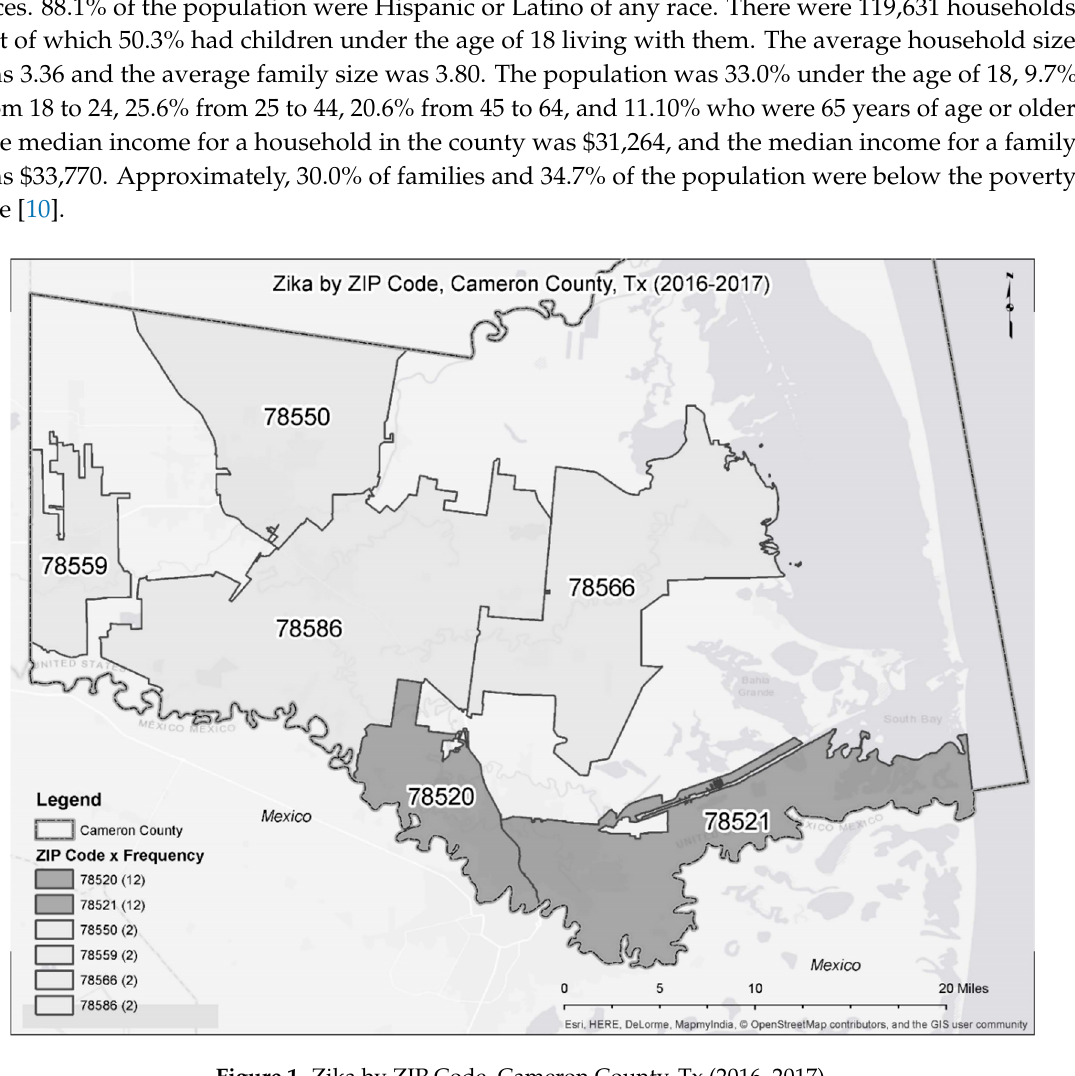
Figure 1. Zika by ZIP Code, Cameron County, Tx (2016–2017).